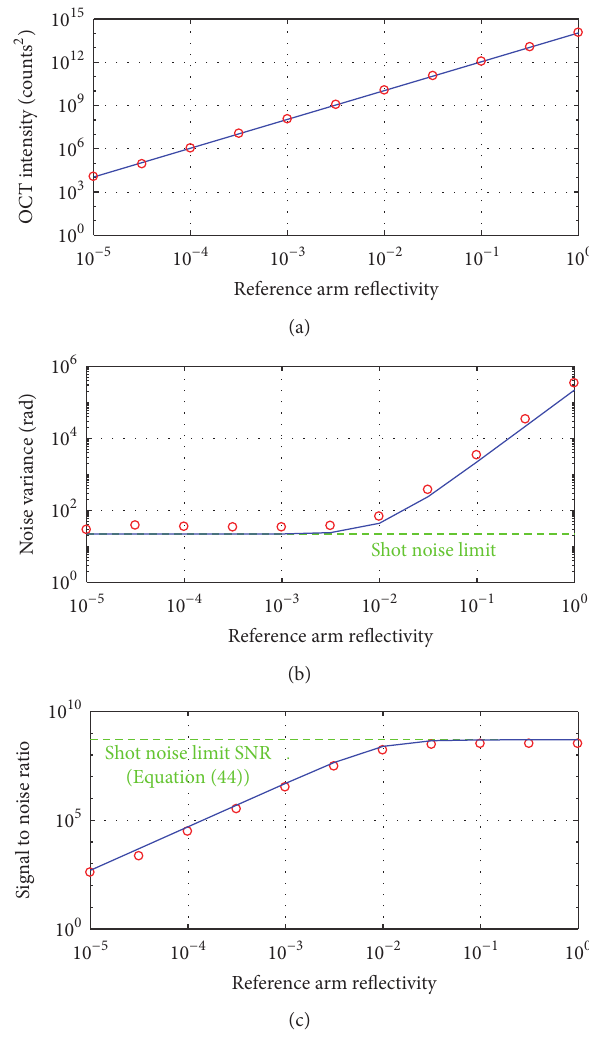
Figure 5: (a) Simulation of the peak of the OCT signal (red circles) compared with the model (blue line). (b) Simulation of the noise of the OCT signal (red circles) compared with the model (blue line). (c) OCT signal to noise ratio simulation (red circles) and the model (blue